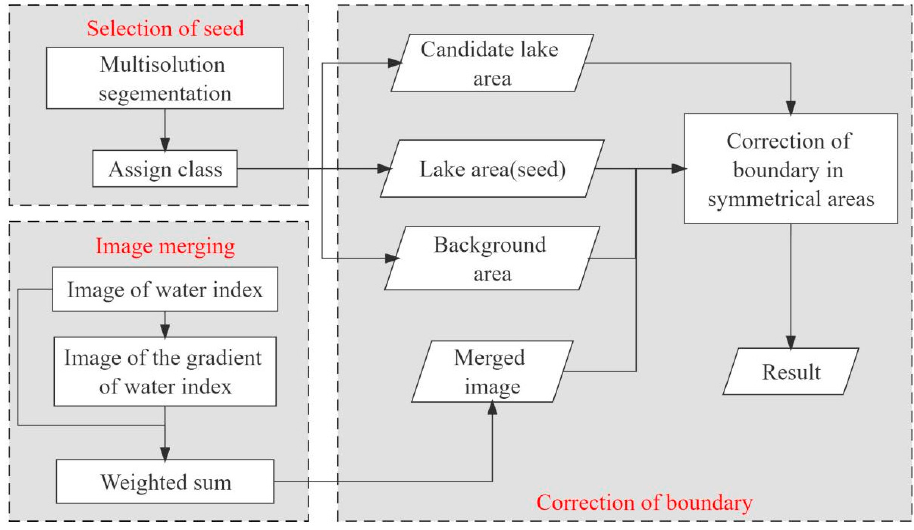
Figure 2. Technology